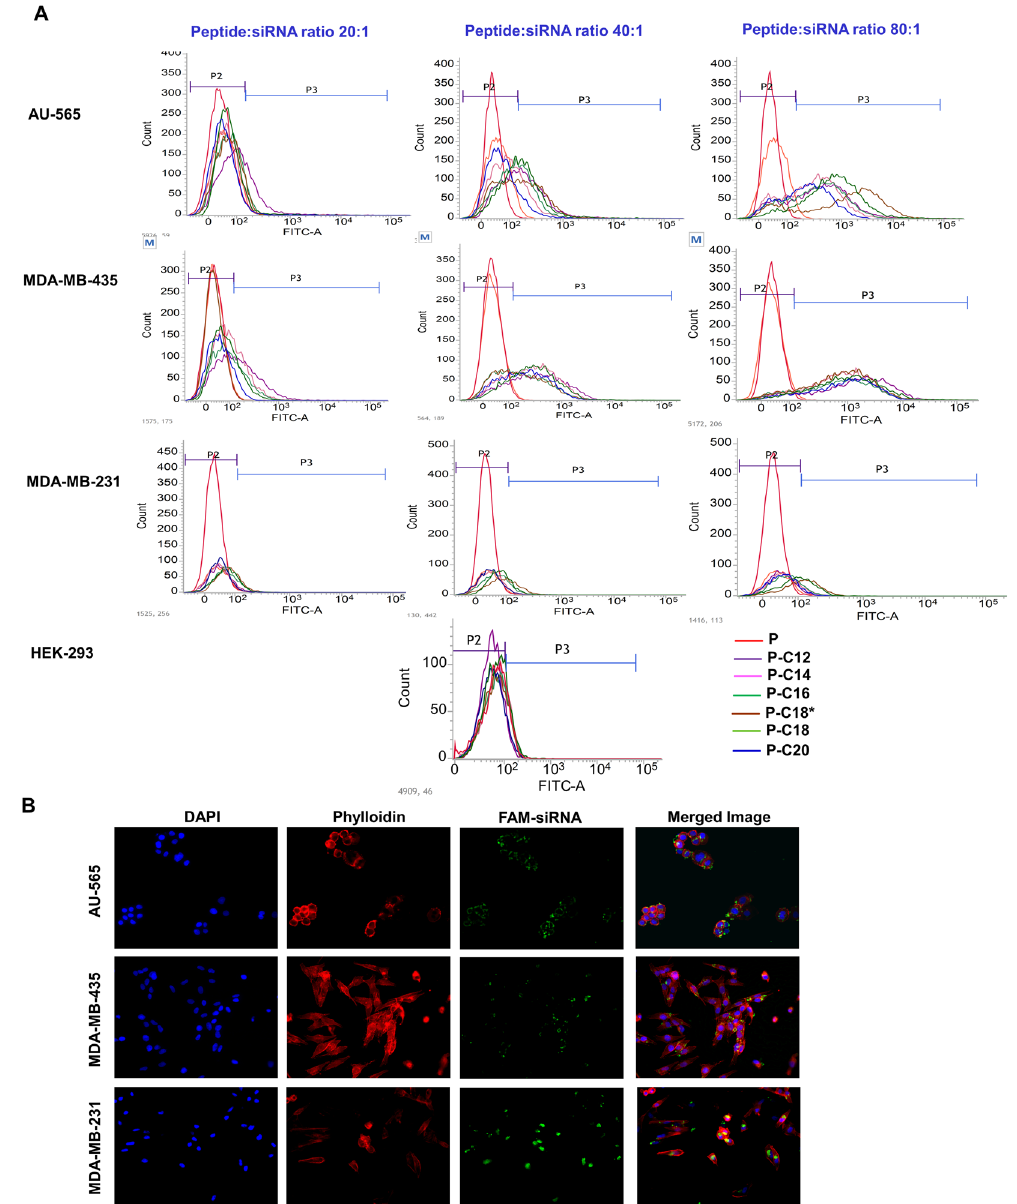
Figure 7. Visualization of uptake of FAM-siRNA. ( A ) Samples of the fluorescence signal for the cell populations for AU565, MDA-MB-435, and MDA-MB-231 cells after 24 h exposure to peptide:FAM-labelled siRNAs at w/w ratios of 20:1, 40:1, and 80:1 (N/P ≈ 27.3, 54.6, and 109, respectively, from left to right). Gates P2 and P3 represent fluorescence of un-treated and FAM-labelled siRNA treated cells, respectively. ( B) Fluorescent microscope images (KEYENCE BZ-X700 all-in-one Fluorescence Microscope; Itasca, IL, USA) demonstrating (from left to right) DAPI-stained nuclei, Texas Red Phalloidin-stained cell membrane, FAM-labelled siRNA, and the merged images from AU565, MDA-MB-435, and MDA-MB-231 cells, after 24 h exposure to complexes formed with P-C18 * peptide:FAM-labelled scrambled siRNA with w/w ratio of 80:1 (N/P ≈